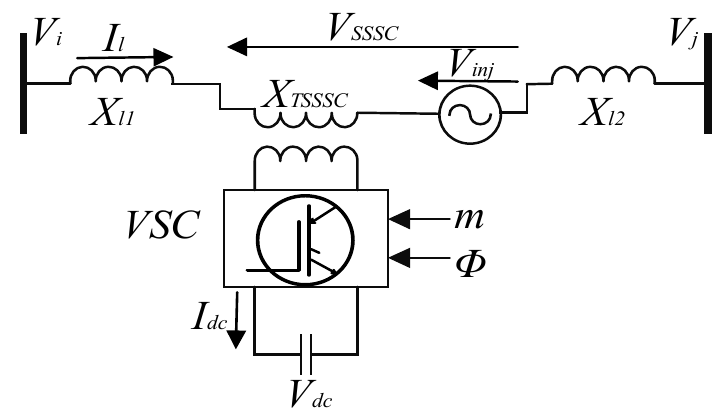
Figure 4. Structure of the SSSC installed between buses i and j .